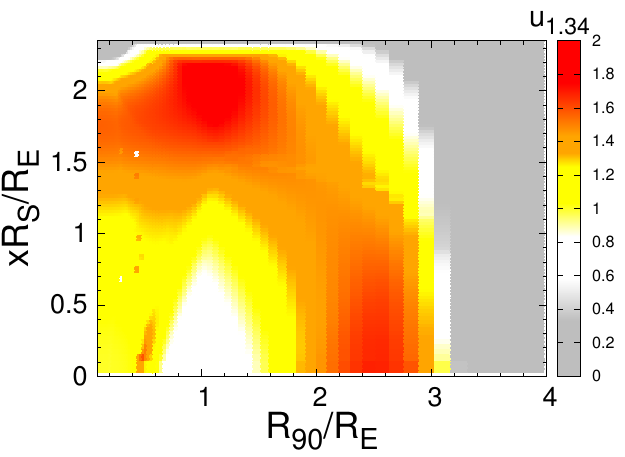
Figure 4 . Values of u 1 . 34 for lensing by FBs. The y -axis is the source radius projected on the lens plane, and 90% of the FB mass is enclosed within radius R 90 . The distances are in units of R E